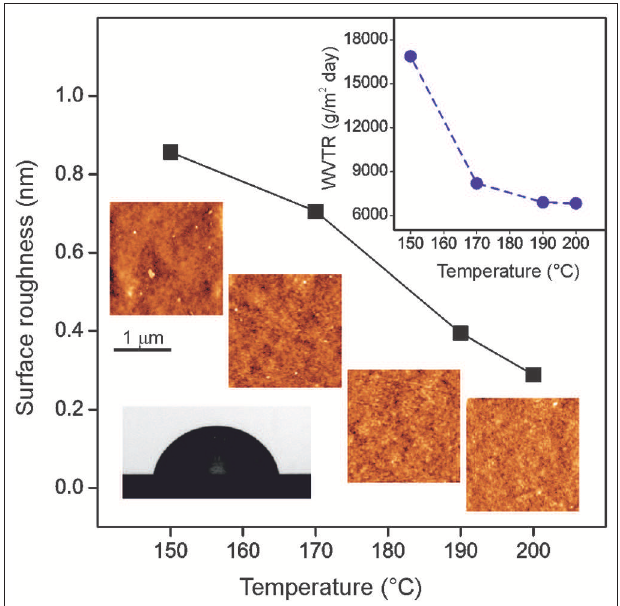
FIGURE 8 | AFM topographic images and surface RMS roughness values of the air exposed side of polyaleuritates synthesized in air for 22h at the indicated temperature. The upper inset shows the normalized water vapor transmission rate of these samples at 25 ◦ C. The lower inset displays the profile of a water drop on top of the air exposed side of a polyaleuritate film.